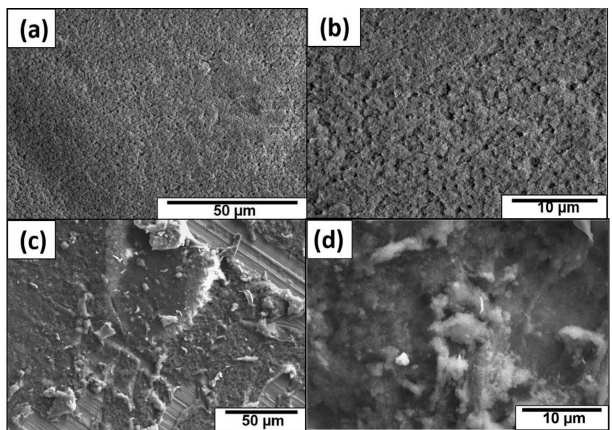
Figure 9. SEM images of the superhydrophobic aluminum surfaces with the Coating B: ( a , b ) surface layer before abrasion at different magnifications; ( c , d ) surface layer after 50 cycles of abrasion at different